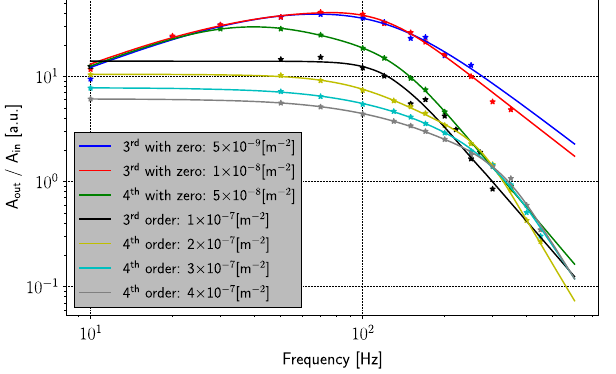
FIG. 10. Two-dimensional transfer map obtained from the fitted transfer functions of Fig. 9, and a bilogarithmic linear interpo- lation. The abscissas and ordinates are respectively the injected ripple frequency and amplitude (in units of normalized quadru- pole strength), while the color code shows the transfer function